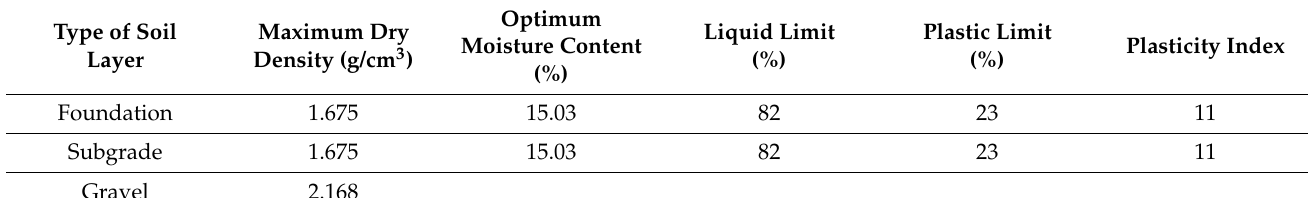
Table 1. The physical properties of various soils for the subgrade with a capillary barrier.